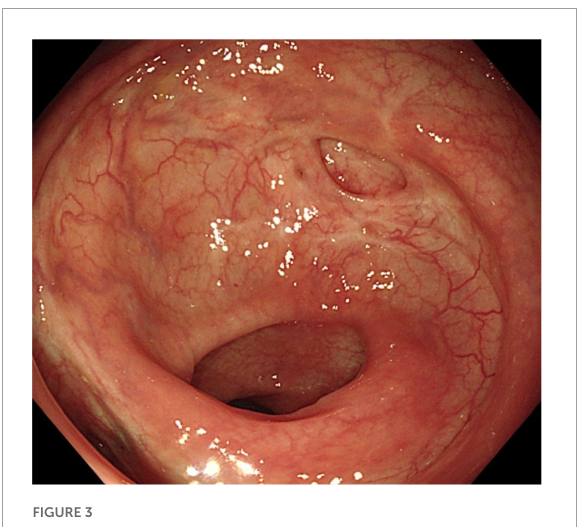
FIGURE3 Endoscopic image of the scar after 1